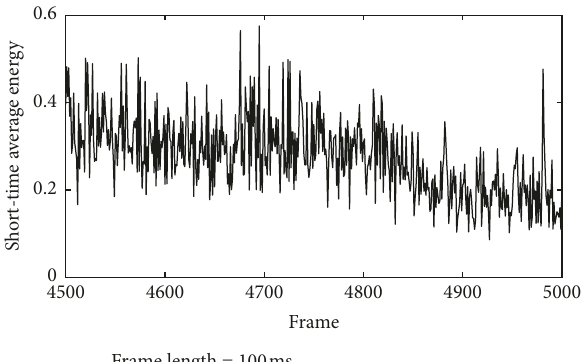
Figure 11: Short-time average energy of time domain signals.